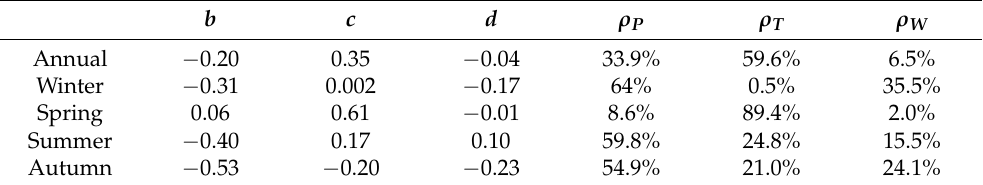
Table 5. PLS regression coefficient and relative contribution rates of climatic variables over MRB in